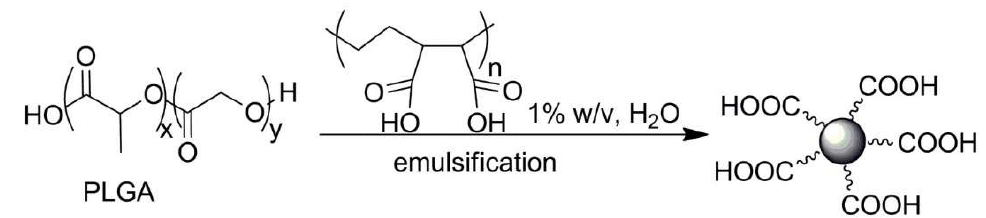
Scheme 28. Schematic illustration of PLGA particles with carboxyl groups.